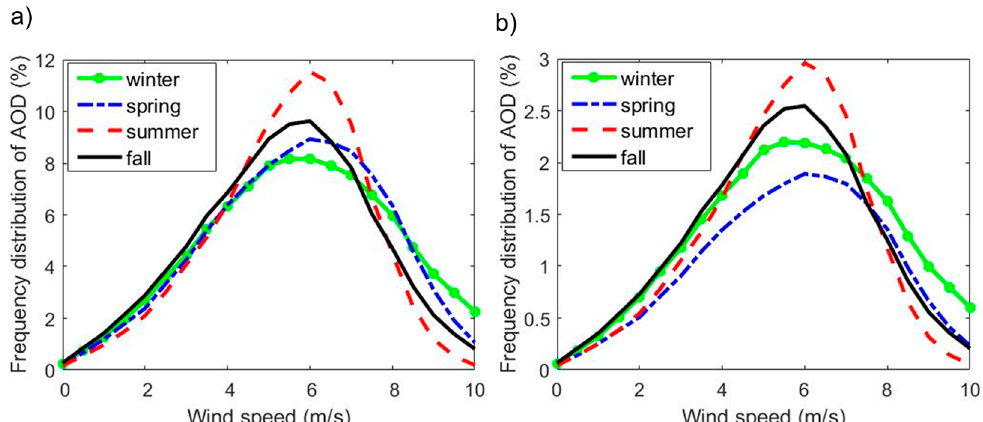
Figure 5. Frequency distributions of all AOD, derived from observations over the Northern Pacific during the period 2003–2016, which have been normalized with respect to the total number of derived AOD corresponding to the ( a ) season and ( b ) year.